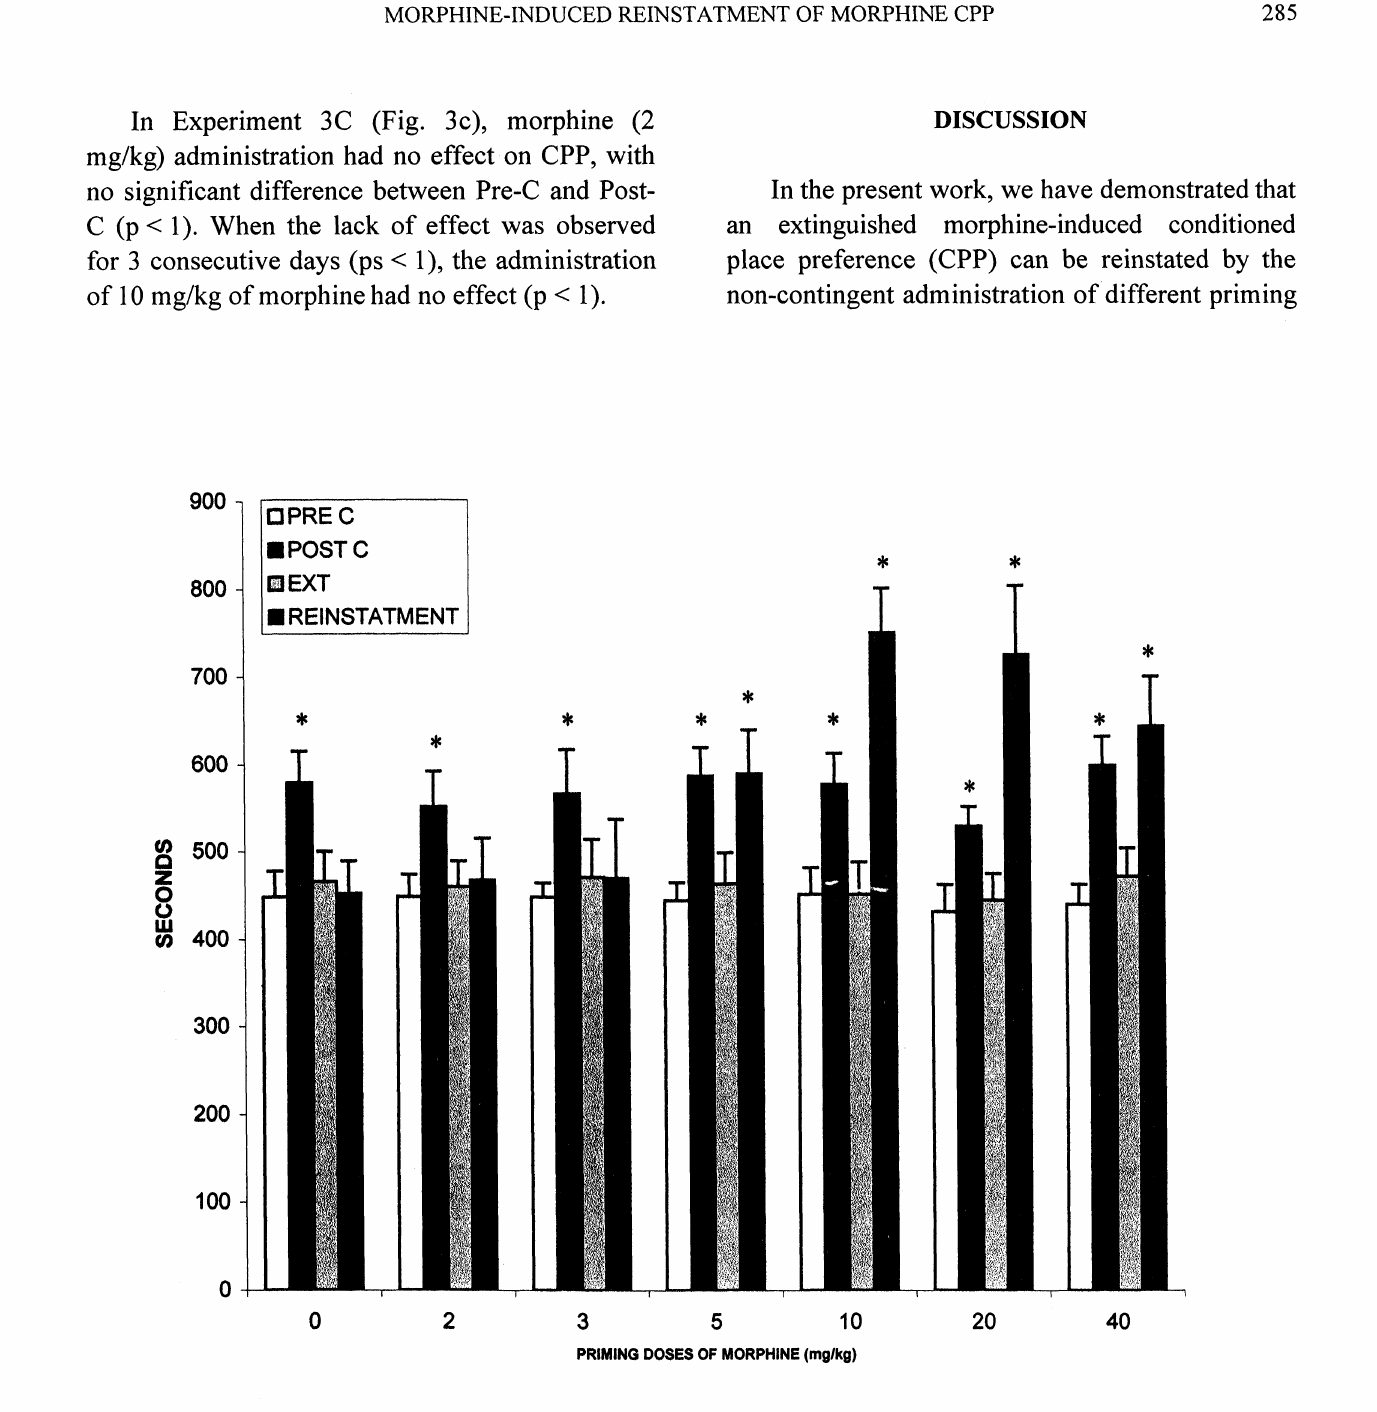
(A) Reinstatement of a previously extinguished morphineinduced CPP by priming doses of morphine. Bars mean (+_SEM) time spent in the drug-paired compartment before conditioning sessions (), after conditioning sessions (), in last extinction session (clear gray), and in reinstatement test (dark gray). Animals were conditioned with 40 mg/kg of morphine and after extinction were tested 30 min after the following doses of morphine (0, 2, 3, 5, 10, 20, 40 mg/kg). * p < 0.01, significant difference in time spent in preconditioning vs. post-conditioning sessions or reinstatement